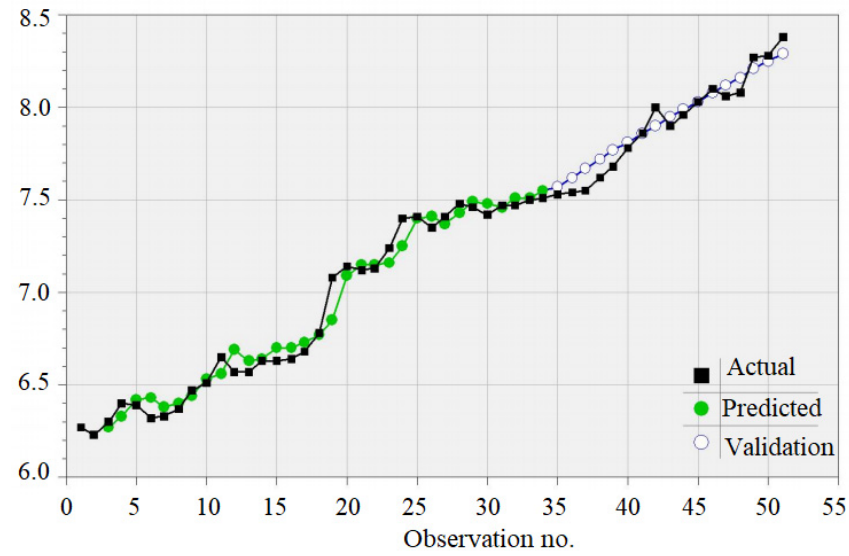
Figure 2. The best model for S1_m (with lag 1 regressor) when a linear trend was removed.